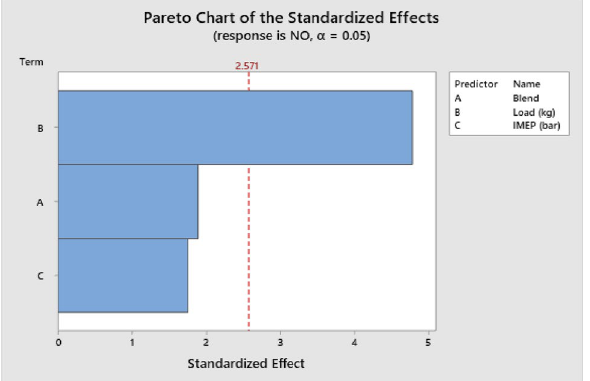
Fig. 21 Regression analysis: NOx versus CuO (nano), load (kg), IMEP (bar) with